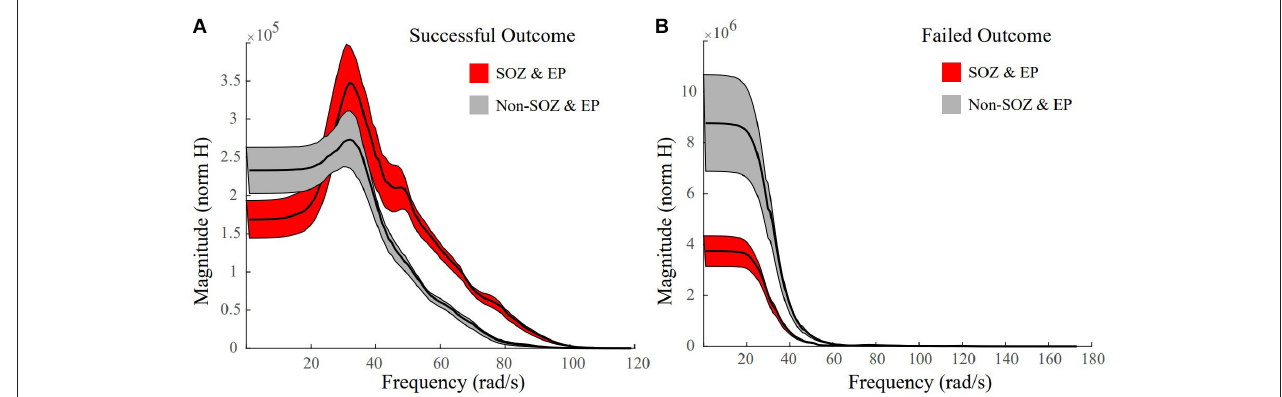
FIGURE 7 | Representative frequency response plots of a successful and failed surgical outcome where red denotes SOZ and EP stimulated datasets, grey denotes non-SOZ and EP stimulated datasets, black is the mean frequency response, and the shaded regions denote ± 2 standard error. (A) Frequency response plot of the SOZ & EP stimulated datasets vs the non-SOZ & EP stimulated datasets for successful surgical outcome Patient 18. The SOZ & EP stimulated datasets show a larger peak gain and a bigger roll off than the non-SOZ & EP counterparts. (B) Frequency response plot of the SOZ & EP stimulated datasets vs the non-SOZ & EP stimulated datasets for failed surgical outcome Patient